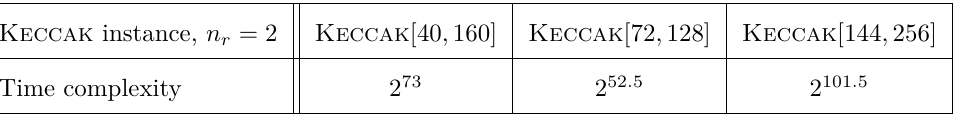
Table 1: Summary of our contribution. The time complexity for our collision attacks is given in number of calls to the Keccak construction when the width is 200 and 400 and when the number of rounds is